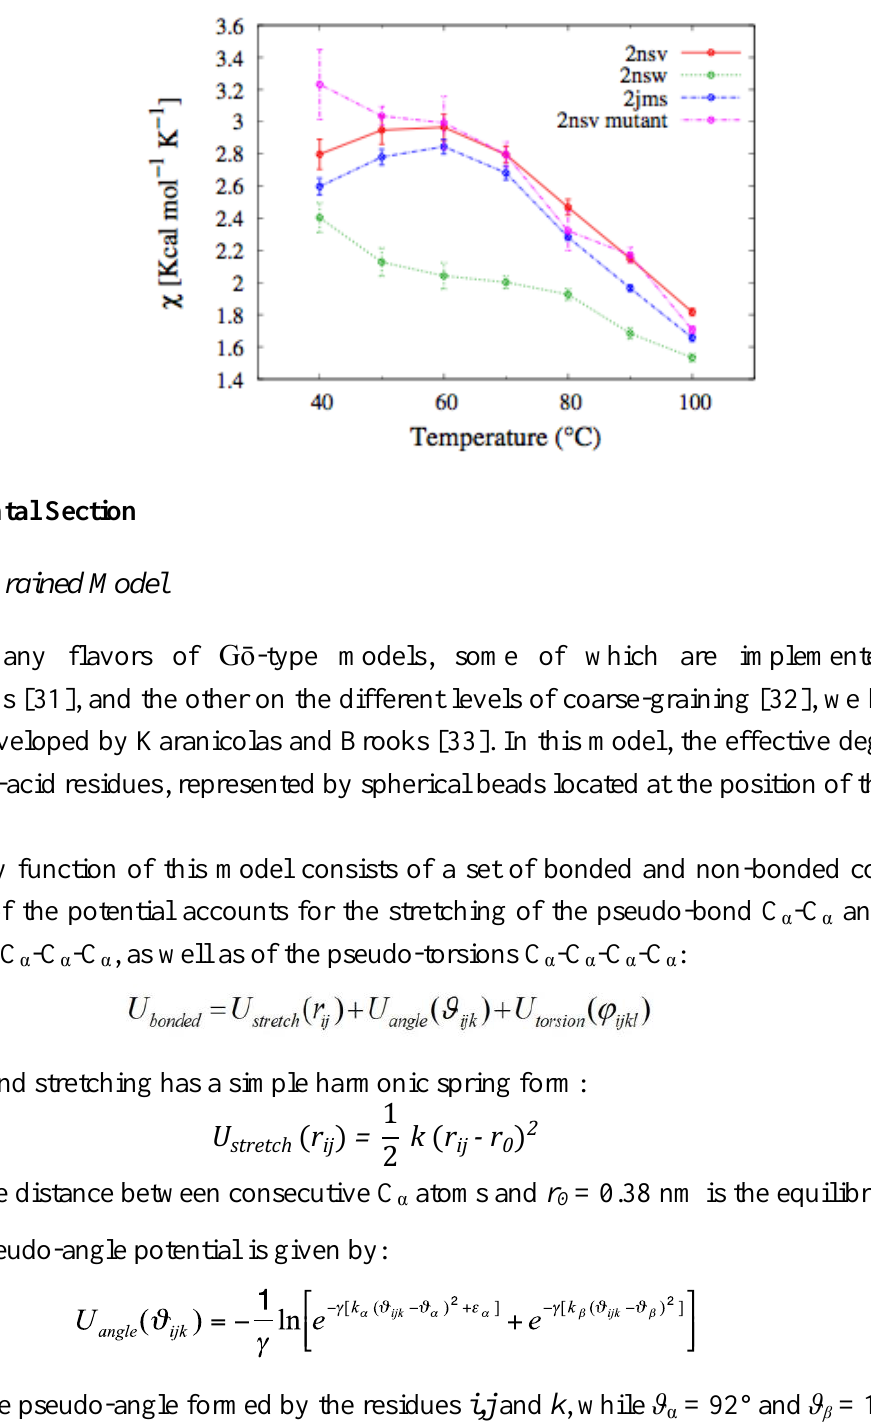
Figure 7. Temperature dependence of the fluctuation in the number of native contacts defined in Equation (1), for the E n pheromones and the mutant of the E n -1 chain. In the mutant, the characteristic peak signaling the unfolding transition